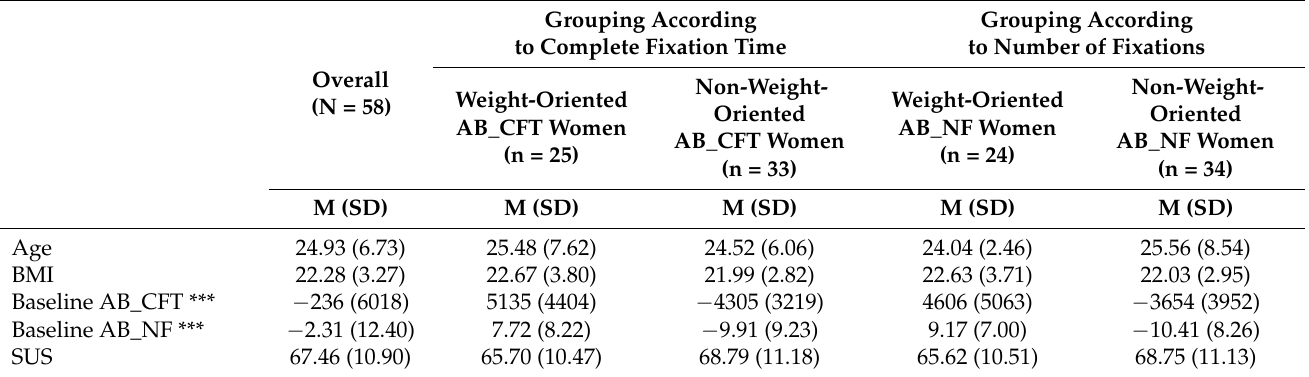
Table 1. Descriptive results: mean (M) and standard deviation